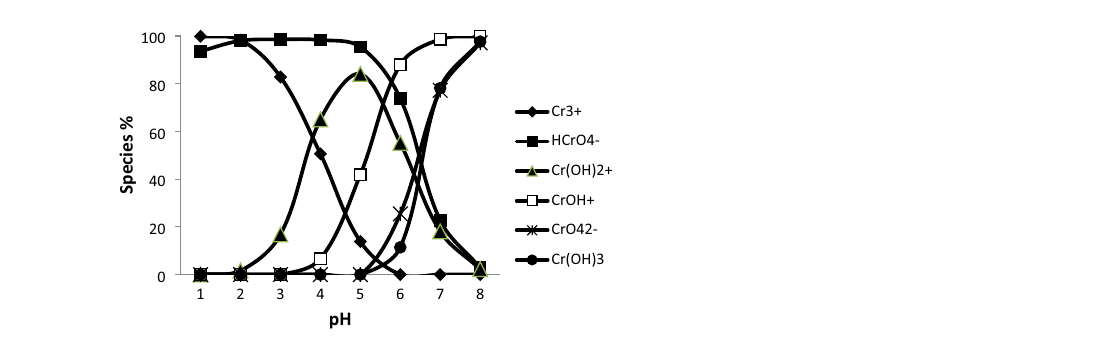
Figure 1. Species % for chromium depends on